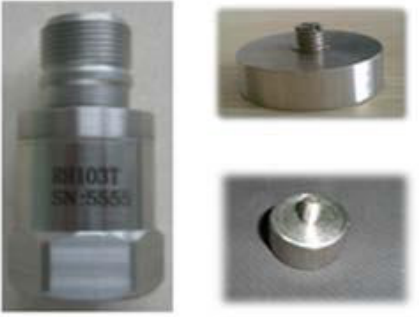
Figure 2. Photos of a vibration sensor and its base used in the main chain of the wind turbine.